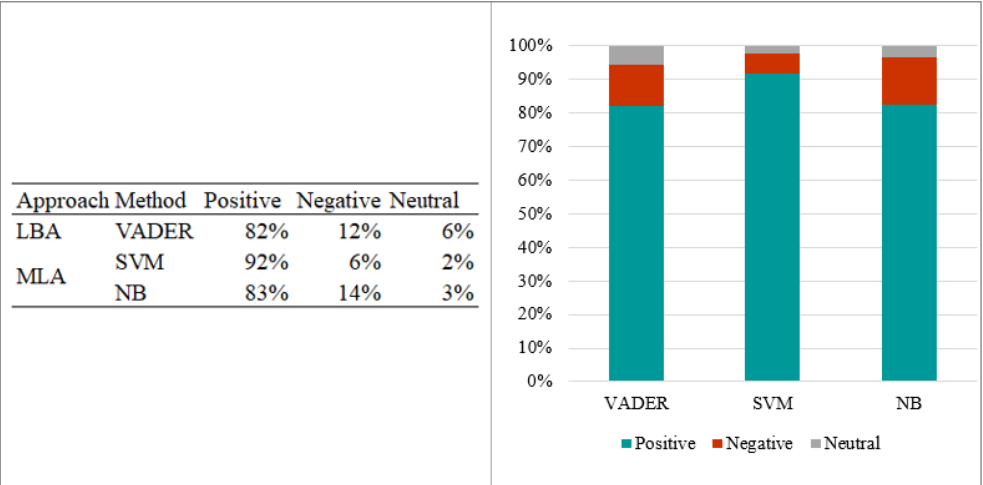
Figure 4. Proportion of opinion polarity by approach.